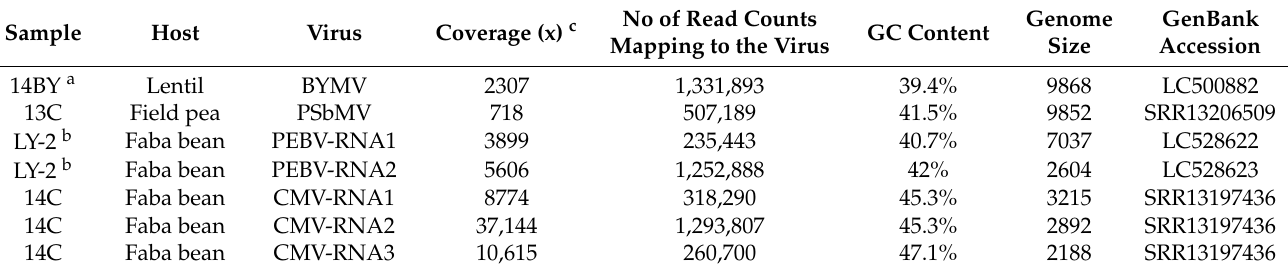
Table 1. RNA-Seq paired-end genome sequence data, including sequence depth coverage, GC content and genome size of the Bean yellow mosaic virus (BYMV), Pea seed-borne mosaic virus (PSbMV), Pea early browning virus (PEBV) and Cucumber mosaic virus (CMV) isolates used in this study for primer design and target template for TG-Seq verification.